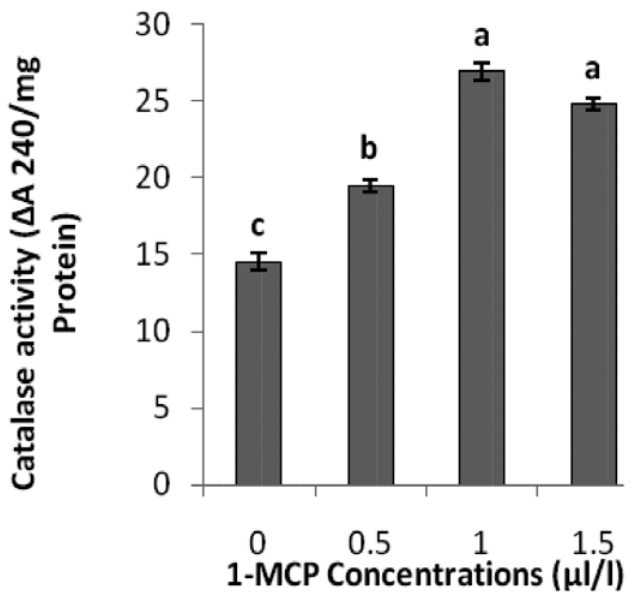
Fig. 5 - Effect of 1-MCP on petal catalase enzyme activity of carnation cv. Fortune.